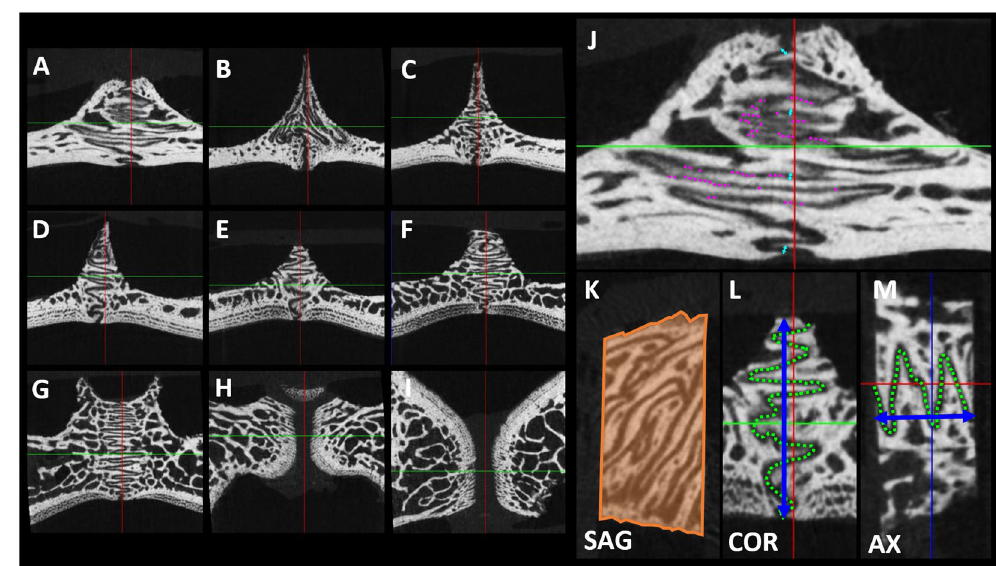
Figure 6. Example images of the µ CT parameters. Series of images on the coronal plane from rostral to caudal ( A-I ). On the sagittal plane: cross section of the specimen ( S 0 , orange area), from which a variable oro-nasal width of the specimen can be appreciated ( K ). On the coronal plane: width of the suture ( Sw COR , light blue arrow) and obliterated length of the suture ( lob COR , dotted violet line) ( J ); oro-nasal width of the specimen ( w COR , blue arrow) and length of the suture ( l COR , green dotted line) ( L ). On the axial plane: rostro-caudal width of the specimen ( w AX , blue arrow) and length of the suture ( l AX , dotted green line) ( Sw AX and lob AX were not represented for simplicity) ( M